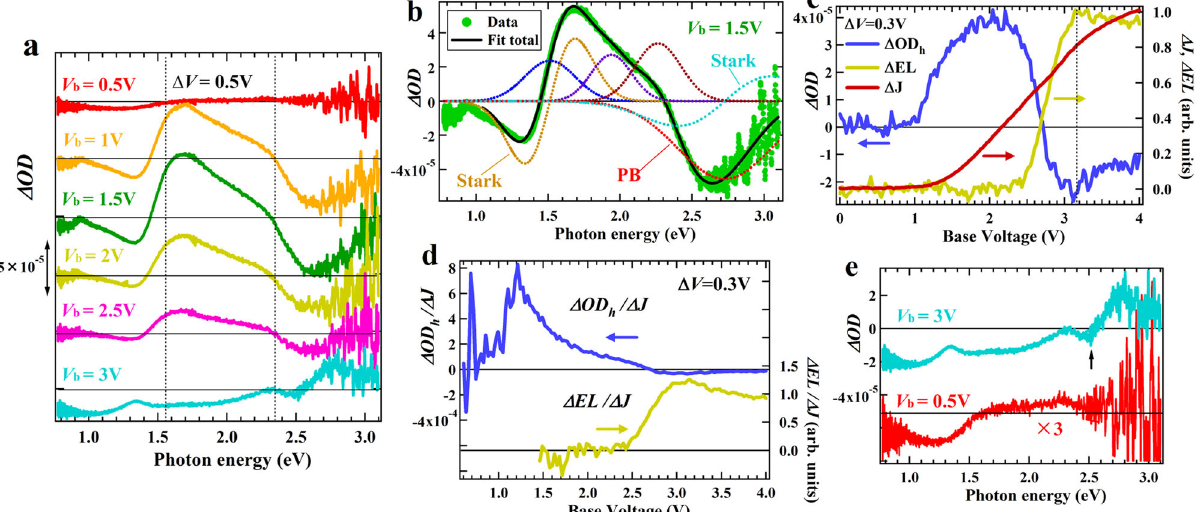
Fig.3|BMspectraobtainedunder1kHzbias-modulation.a BMspectraobtained forthe SY-LECat a base voltage ( V b ) of0.5 to 3.0V under the voltage width ( Δ V ) of 0.5V. b Result of fi tting the spectrum at V b =1.5V with three absorptions and two Stark and one photo-bleaching (PB) components. c V b -dependence of the hole signal intensity at 1.55eV induced by under the modulation of Δ V =0.3V ( Δ OD h )